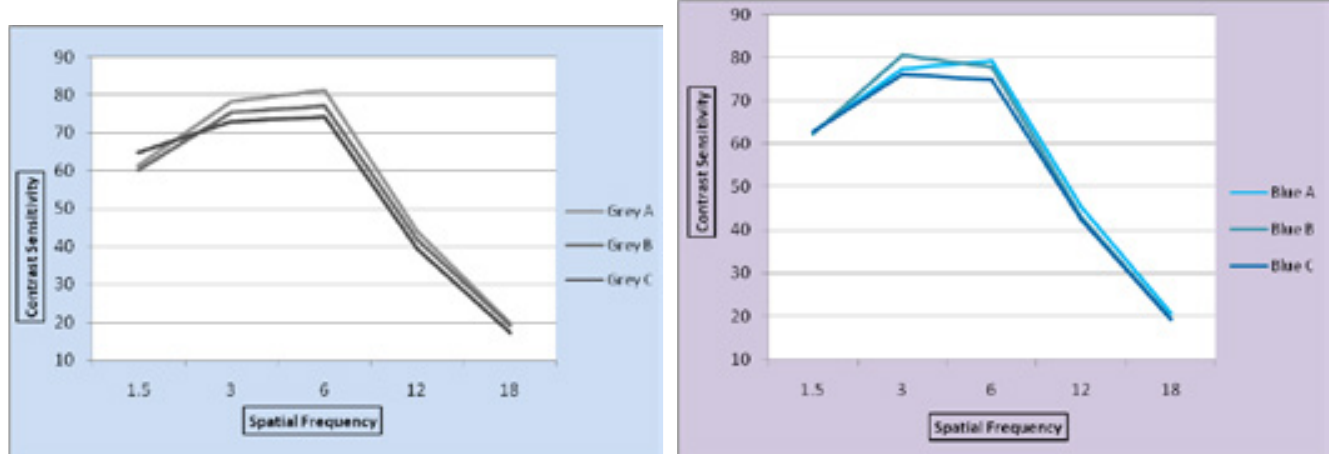
the same colour tint affect contrast sensitivity.